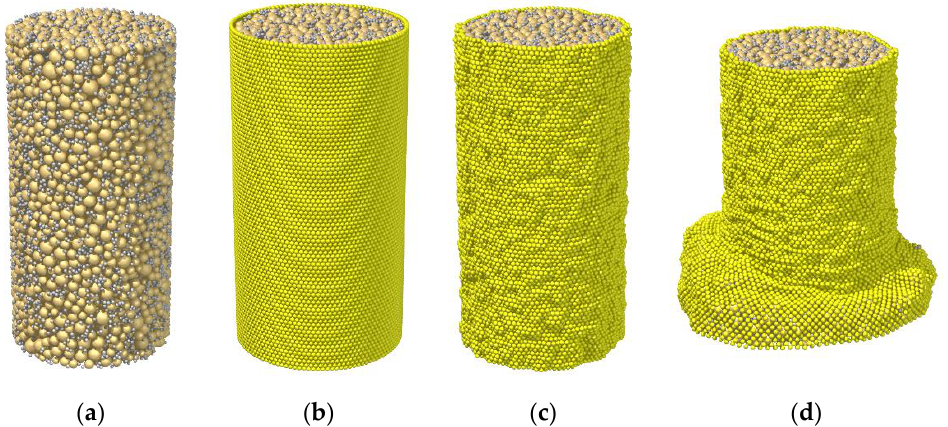
Figure 2. Simulation process: ( a ) sample preparation; ( b ) membrane boundary establishment; ( c ) consolidation; ( d ) triaxial compression test. Table 2. Parameters of the samples with different initial